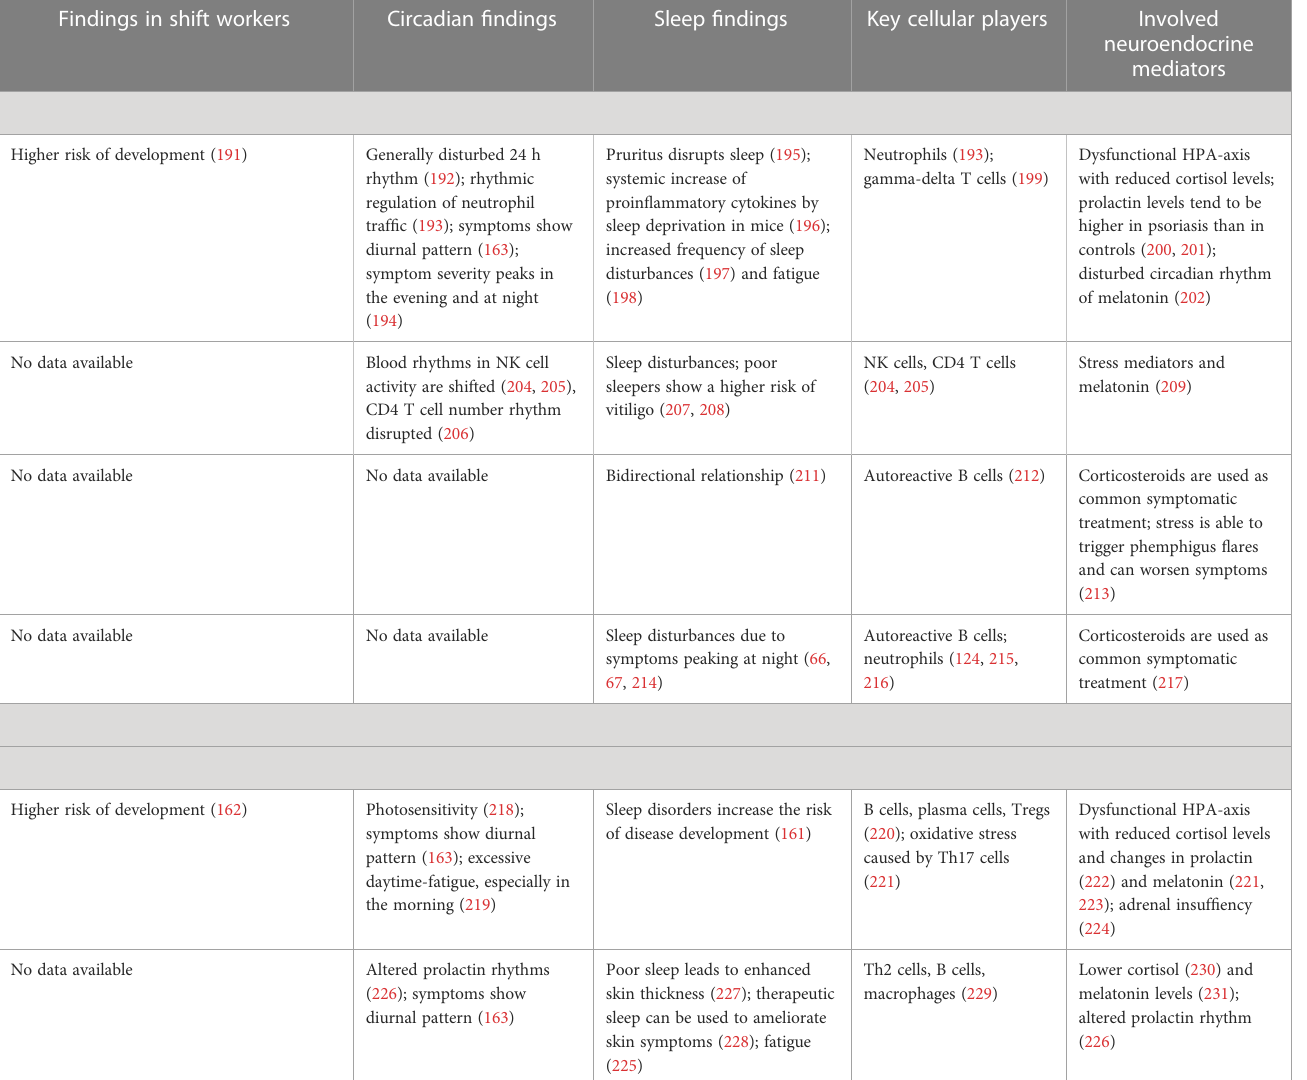
TABLE 2 Effects of shift work, circadian or sleep disturbances on autoimmune (skin)